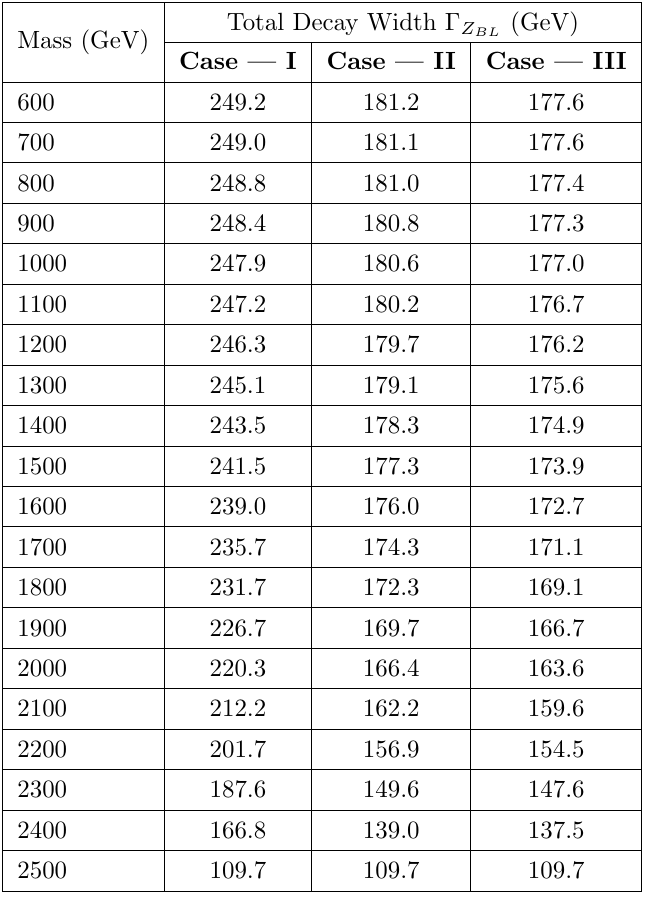
Table 5 . Decay widths of Z BL for di(cid:11)erent benchmark values of DM and fermion triplet masses.